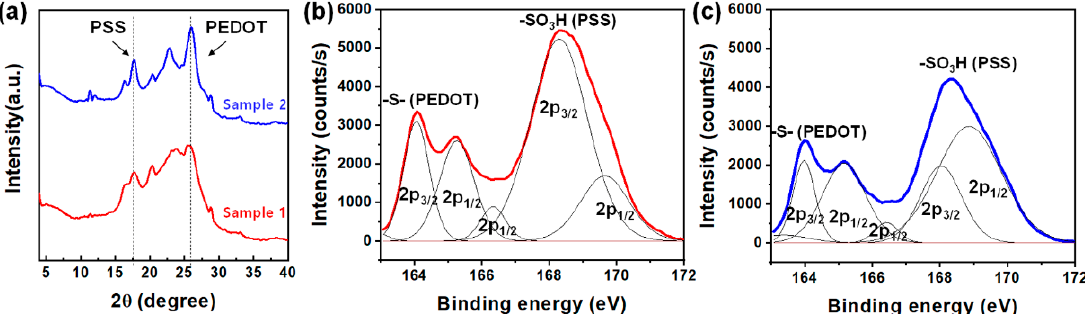
Figure 4. ( a ) X-ray diffraction (XRD) scans of E-textiles, ( b ) X-ray photoelectron spectroscopy (XPS) spectra of sample 1, and ( c ) XPS spectra of sample 2. ( c ) XPS spectra of sample